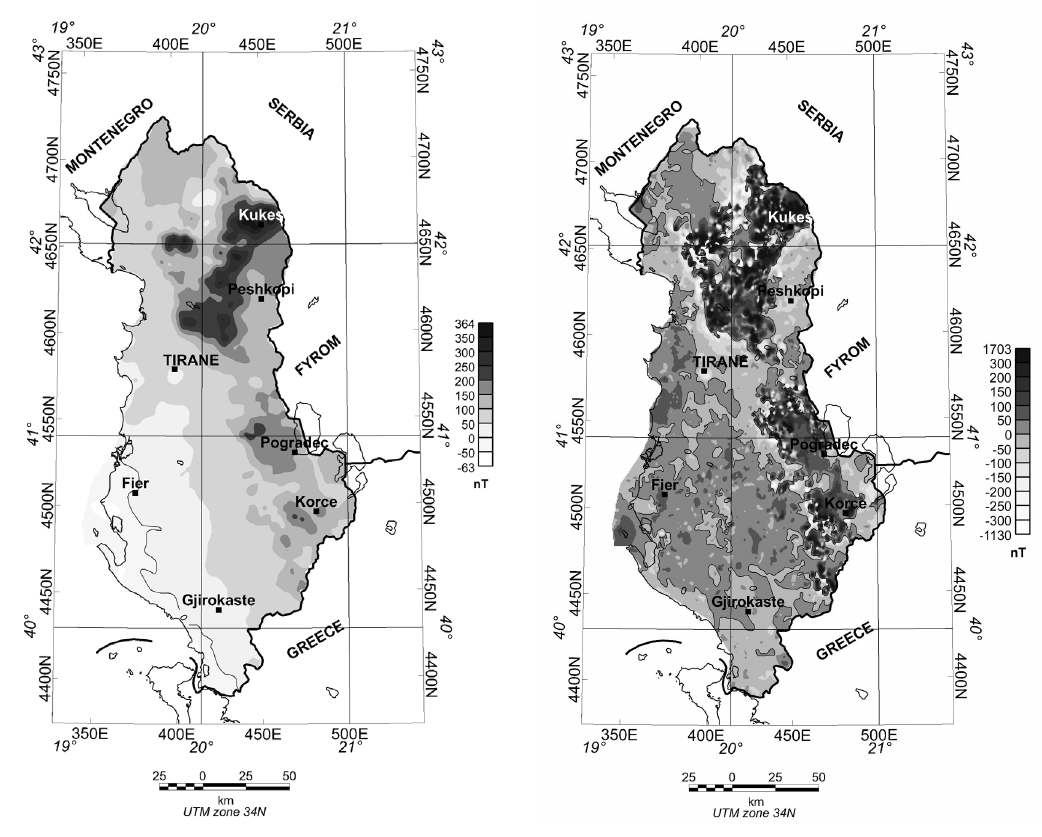
Fig. 8. Reduced to the pole total magnetic field anomaly of